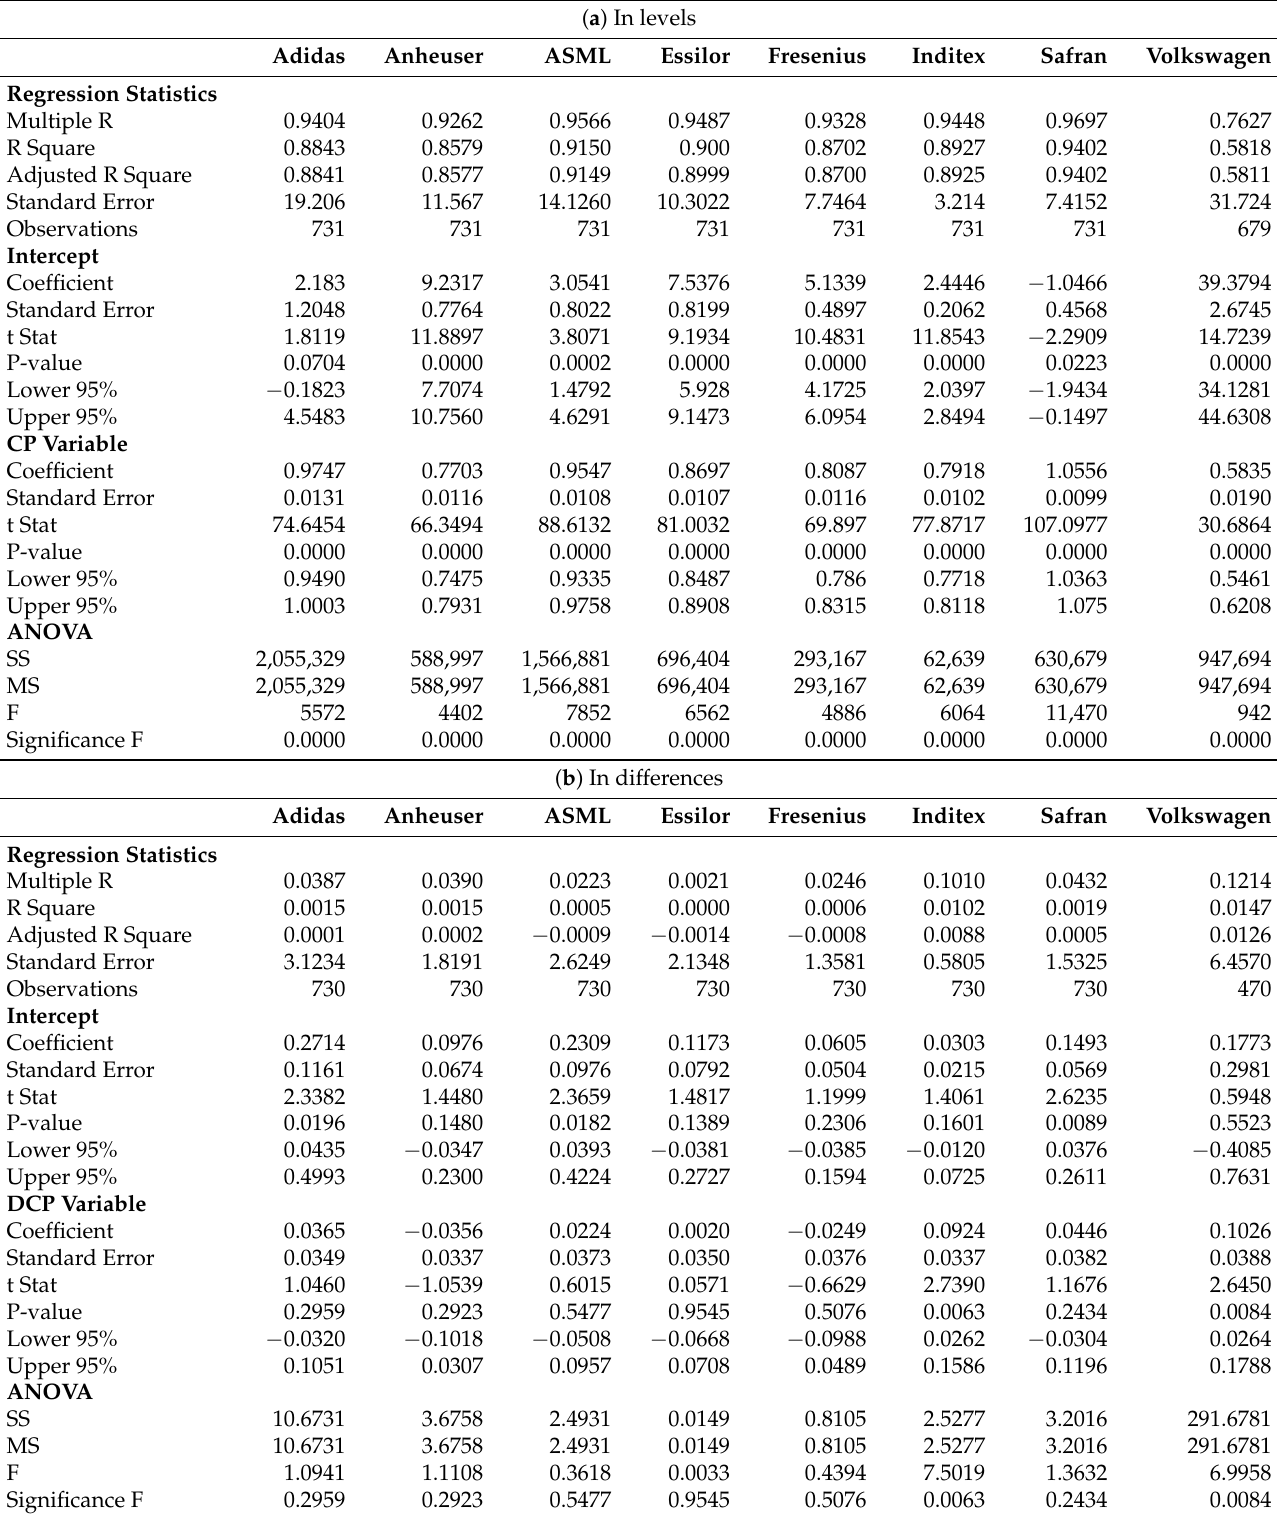
Table 6. Future prices vs. capitalised prices: individual asset results. Individual regressions of future prices (FP)